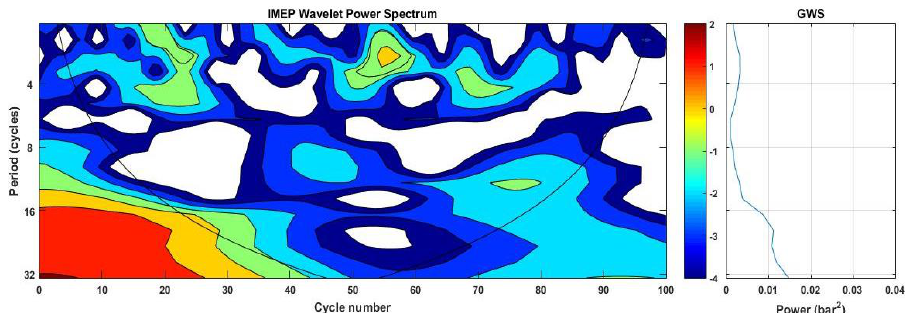
Figure 6. Wavelet analysis of IMEP (WPS and GWS), 10MPa_240BTDC_1500_Clean.